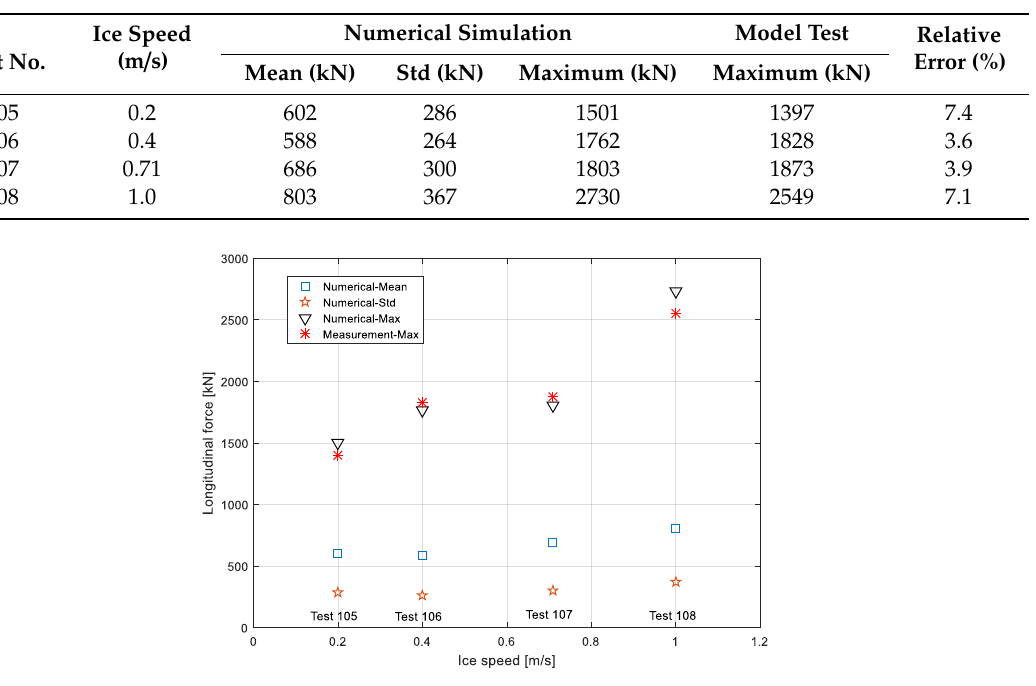
Table 2. Statistics for the simulation and model test data.